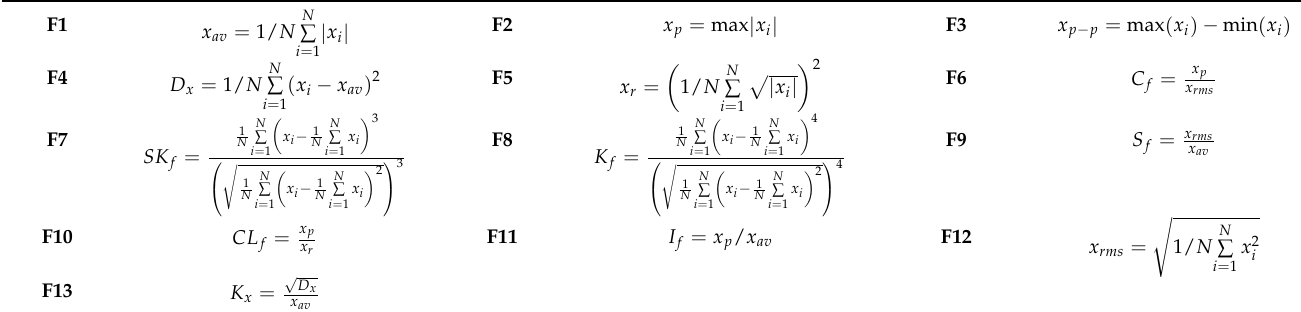
Table 1. Time domain and frequency domain statistics feature. (1) X av : average value; (2) X p :